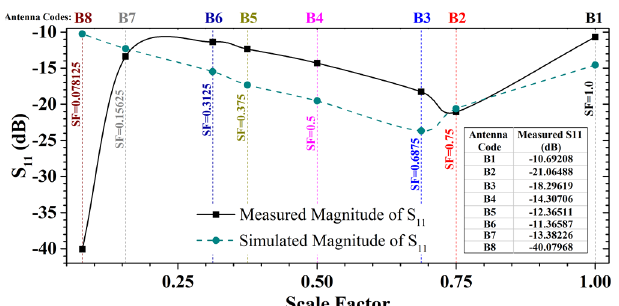
Figure. 6. Dependency of measured and simulated S 11 magnitude to the scale factor.